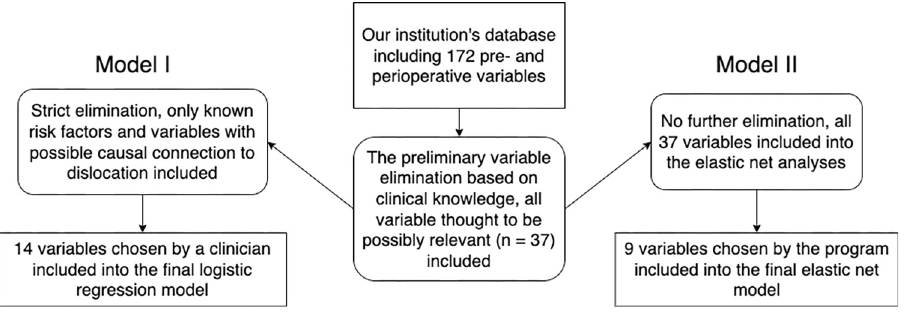
Fig 1. The flow chart summarizing the predictor variable choice for Model I and Model